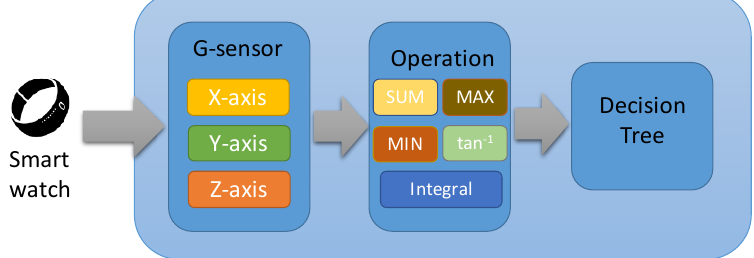
Figure 2. Flowchart of hand-gesture recognition.